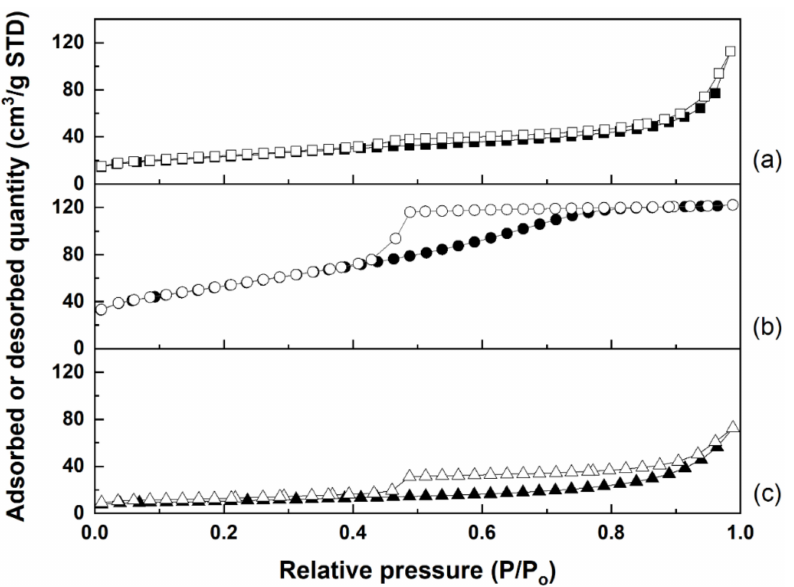
Figure 4. Nitrogen adsorption–desorption isotherms of MoS 2 samples prepared at ( a ) pH 4.5; ( b ) pH 7.0; and ( c ) pH 9.5 (The open and filled symbols denote adsorption and desorption, respec- tively).